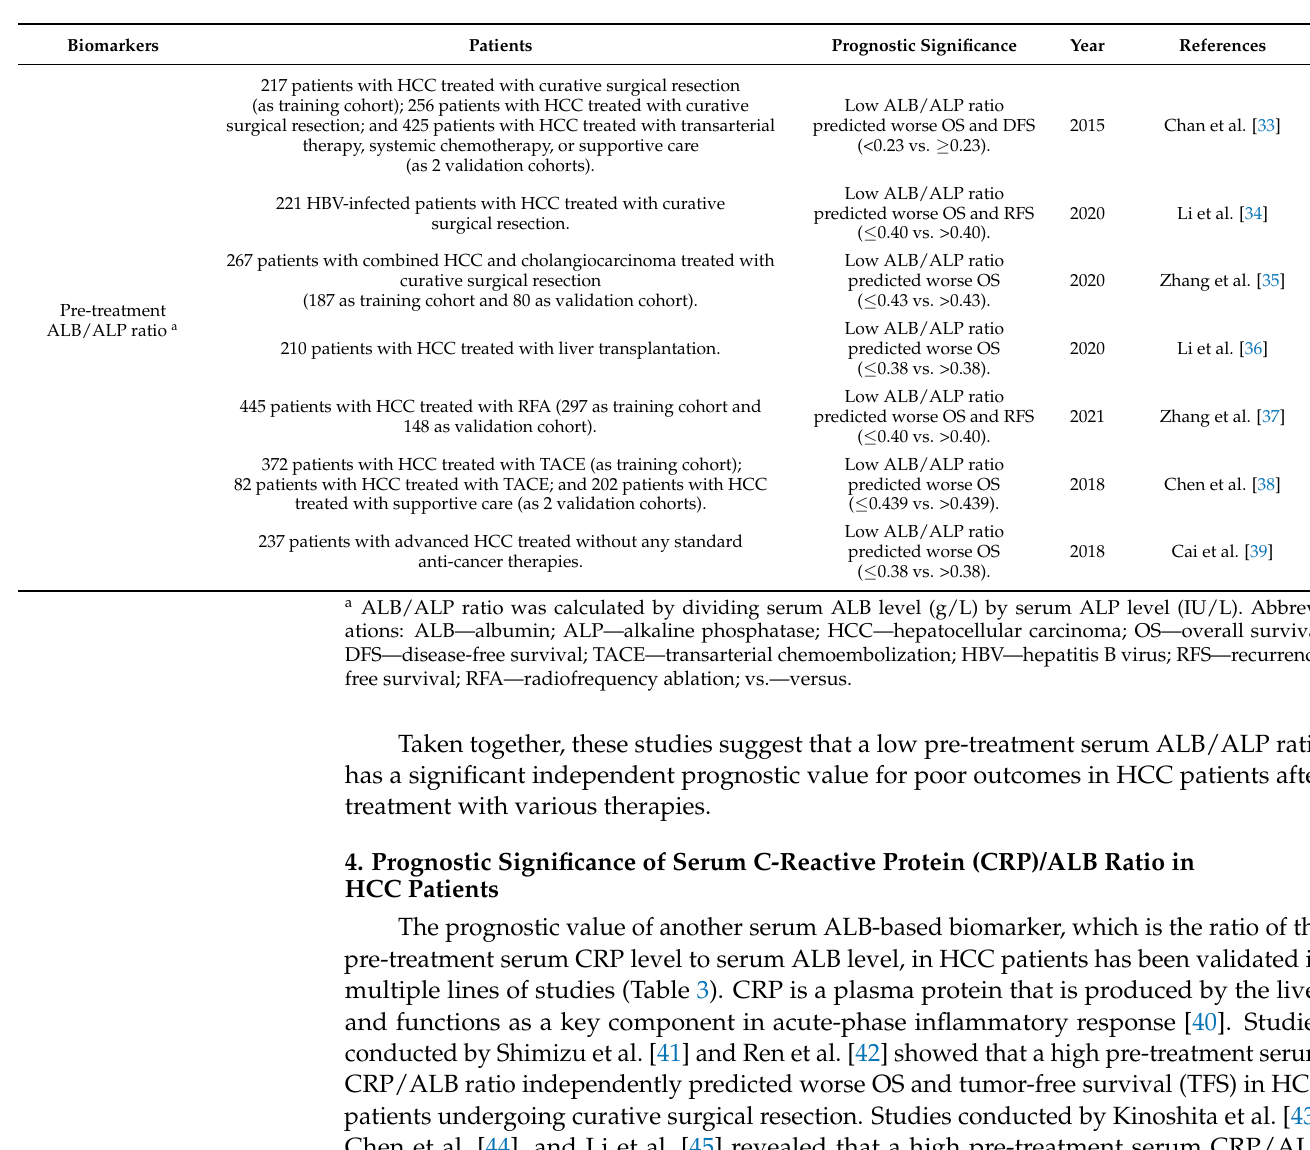
Table 2. Prognostic significance of serum ALB/ALP ratio in HCC